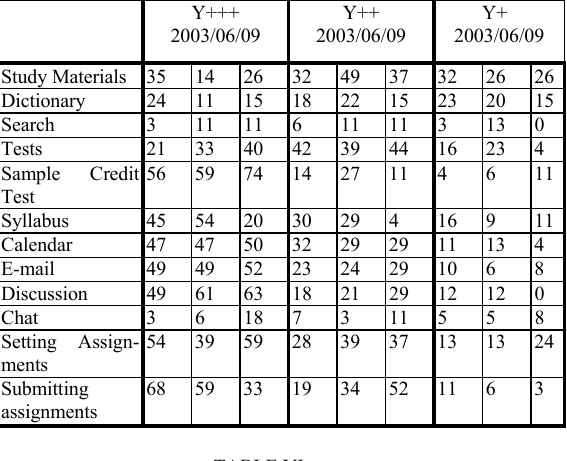
TABLE VI. E VALUATION OF STUDENTS ´ DISSATISFACTION WITH LMS TOOLS (%)